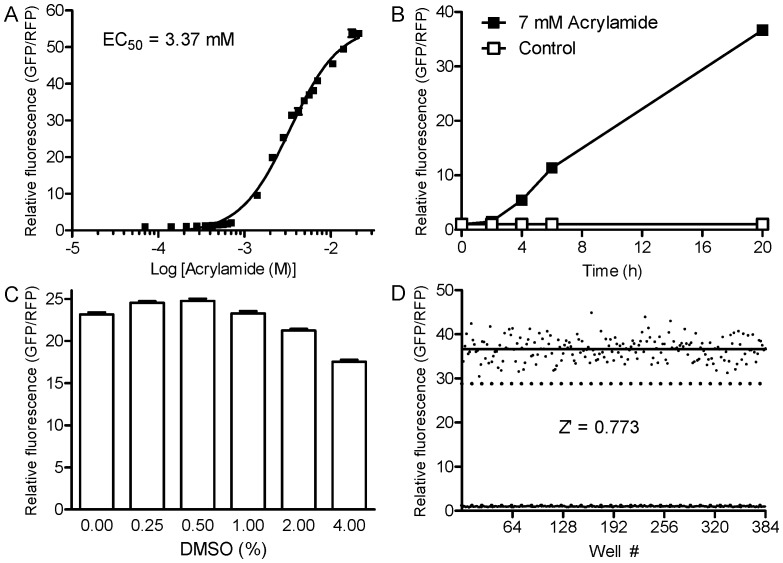
Activation of Pgst-4::GFP by acrylamide is robust and consistent.L4 larval to young adult stage worms were diluted to approximately 2–3/µl and 30 µl was dispensed into every well of a 384 well plate. GFP and RFP fluorescence were measured after 21 h. (A) Fluorescence was measured with different concentrations of acrylamide (n = 16 wells). (B) Seven mM acrylamide was added in every other column to measure fluorescence at 0, 2, 4, 6 and 20 h (n = 192 wells). (C) Fluorescence was measured with 7 mM acrylamide and different concentrations of DMSO (n = 64 wells). 2 and 4% DMSO decreased induction relative to control, P<0.001. (D) Assay consistency is shown using a scatter plot to compare the fluorescence of acrylamide-treated (7 mM) worms to that of control worms (n = 192 wells per treatments). The mean relative fluorescence ratios of all control (1.0) and acrylamide wells (36.7) are marked with solid lines. Three standard deviations above the control mean and below the acrylamide mean are marked with broken lines. Values are means ± SEM (A–C) or individual data points (D).